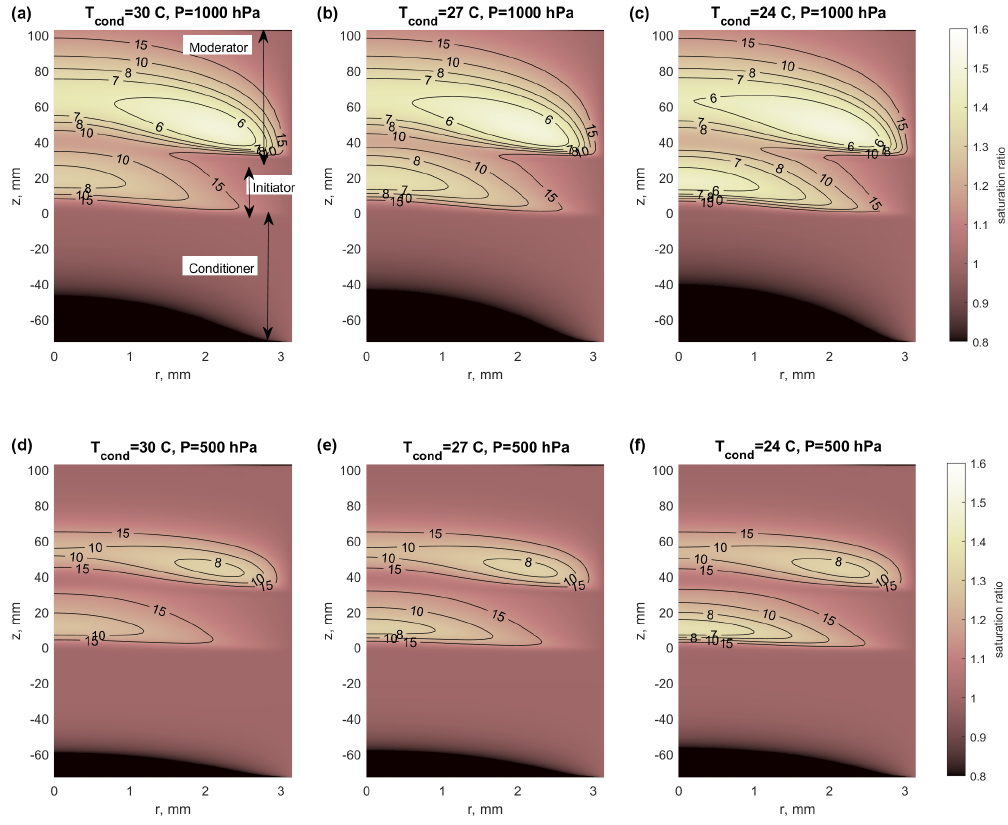
Figure 4. Simulation of the CPC 3789 saturation ratio profiles at 1000hPa (a–c) and at 500hPa (d–f) under the different conditioner temperatures (30, 27, and 24 ◦ ) with the initiator temperature at 59 ◦ and the moderator temperature at 10 ◦ . The color bar indicates the humidity (the saturation ratio) change inside the three-stage growth tube. The contour line indicates the saturation ratio necessary to activate 6, 7, 8, 10, and 15nm seed particles. r is the distance from the centerline. z is the distance from the entrance of the initiator, which means that the conditioner is from − 73 to 0mm.